Question: Write a single sentence explaining what this figure depicts.
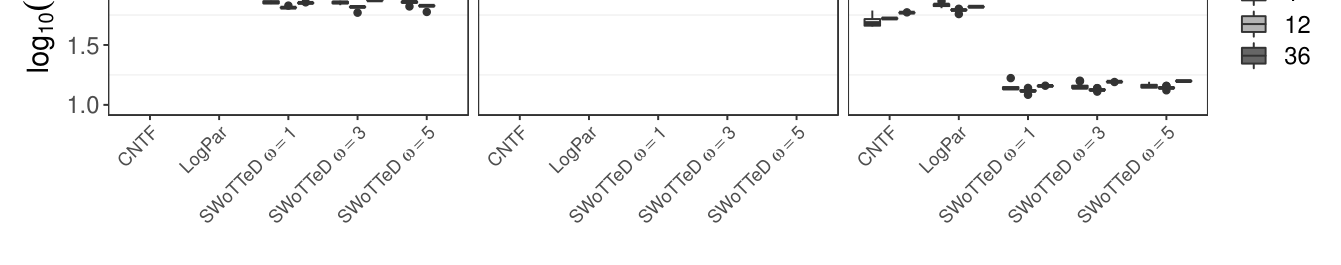
Answer: Computing time in seconds (base-10 log-scale) of one run of SWoTTeD and its competitors.